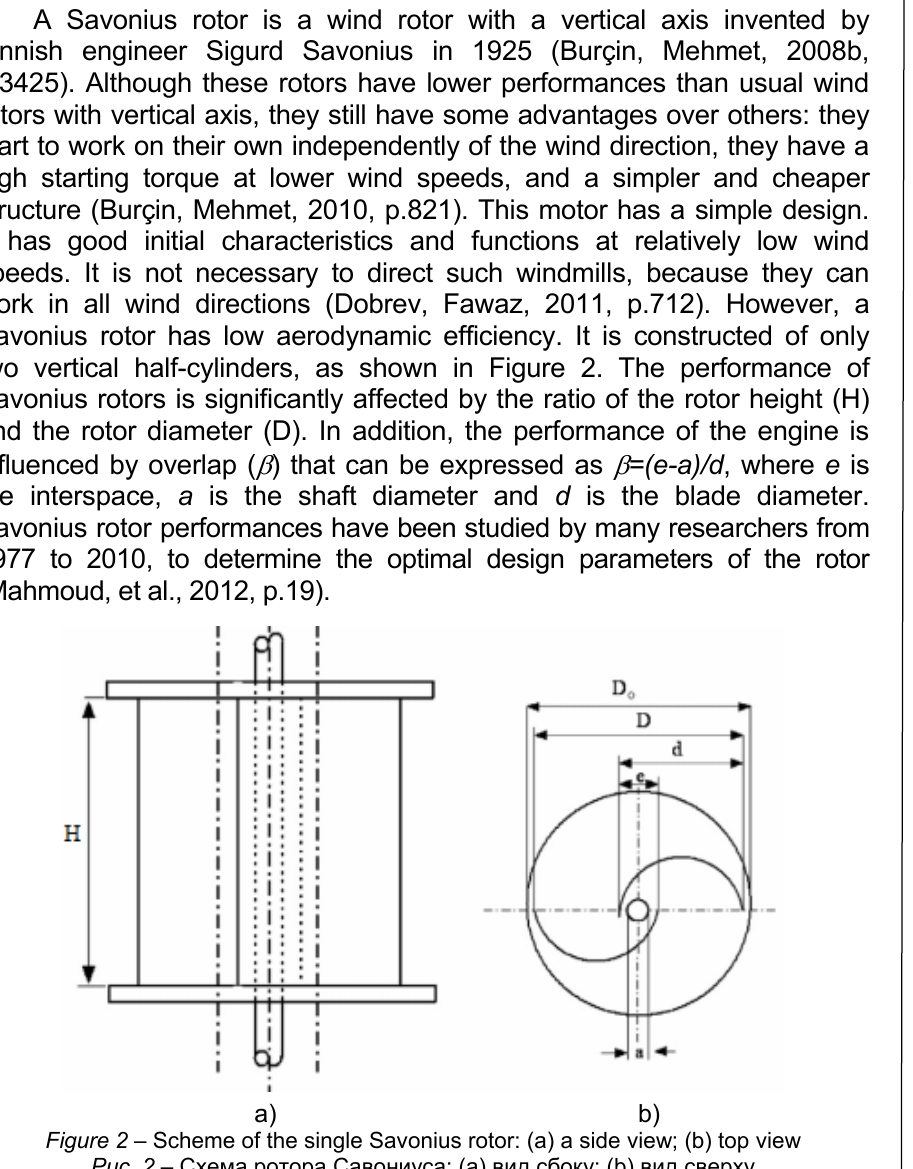
Figure 2 – Scheme of the single Savonius rotor: (a) a side view; (b) top view Рис . 2 – Схема ротора Савониуса : (a) вид сбоку ; (b) вид